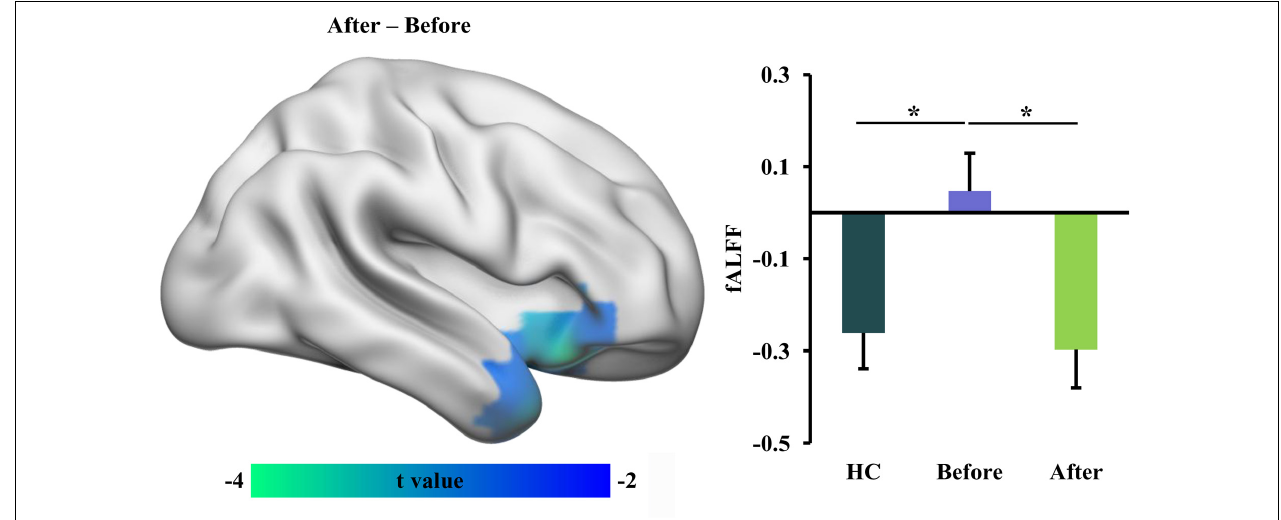
FIGURE 1 | Decreased fractional amplitude of low-frequency fluctuation (fALFF) in restless leg symptom (RLS) patients after transcutaneous spinal cord direct current stimulation (tsDCS). Paired t -test was performed and identified significantly decreased fALFF in right anterior insula (INS)/temporal pole (TP) in RLS patients after tsDCS compared to that before tsDCS. Regional mean fALFF values in the right anterior INS/TP were calculated in healthy controls (HC) and RLS patients before and after tsDCS, and two-sample t -tests were performed between HC and RLS patients before and after tsDCS and found decreased fALFF in HC compared to RLS patients before tsDCS treatment. No significant difference in fALFF between HC and RLS patients after tsDCS was found. * p < 0.05.